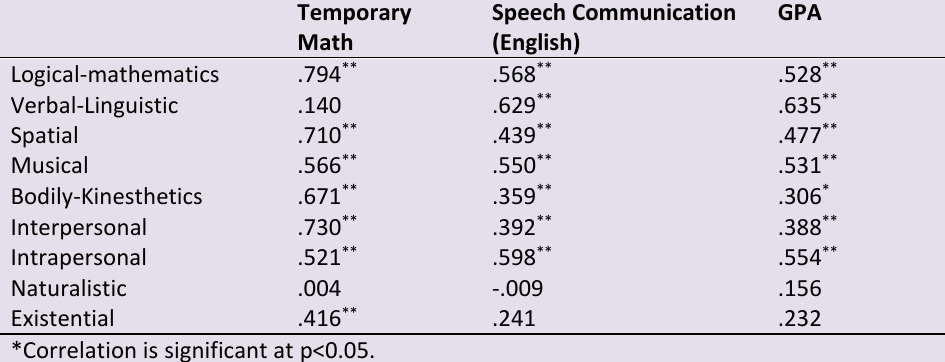
Table 5. The relationship of the multiple intelligences and the performances Temporary